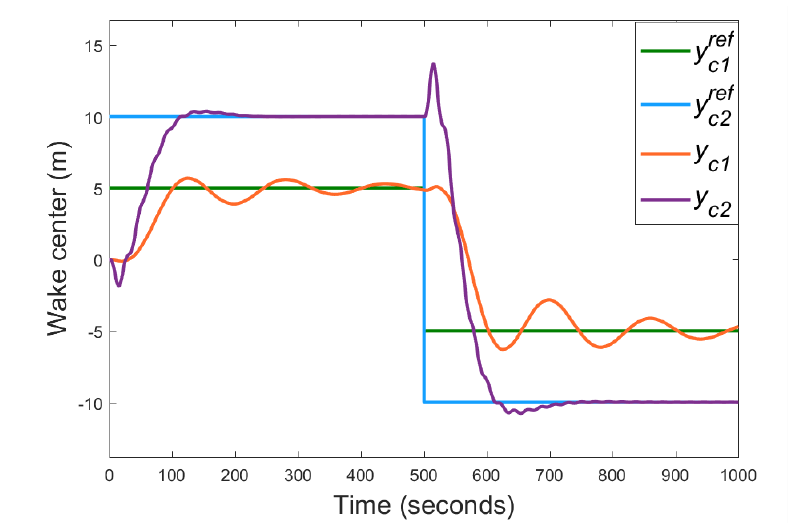
Figure 14. Wake center estimation for upwind turbines WT 1 and WT 2 .